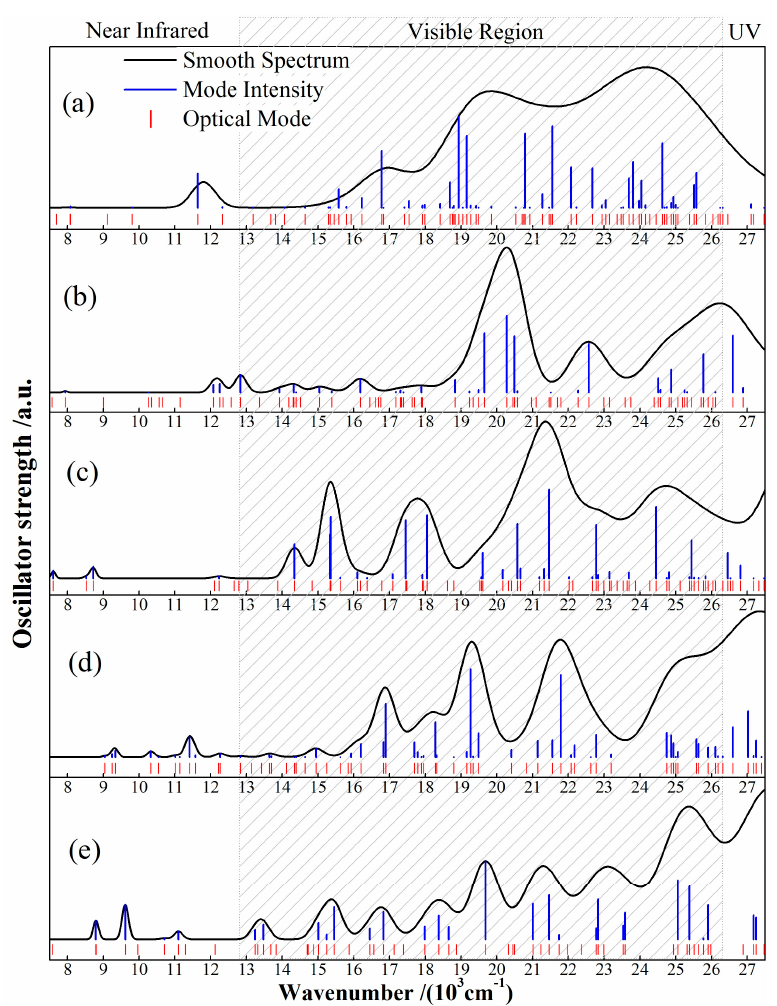
Figure 7. The calculated optical absorption spectra of CTTC in ( a ) +2, ( b ) +3 ( c ) +4, ( d ) +5 and ( e ) +6 redox states.